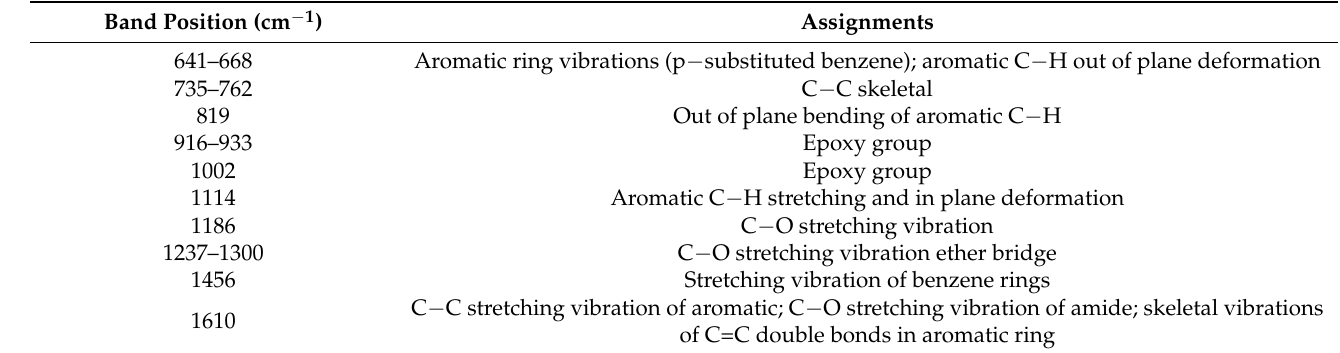
Table 4. Raman bands assignments for the examined CFRP laminates.